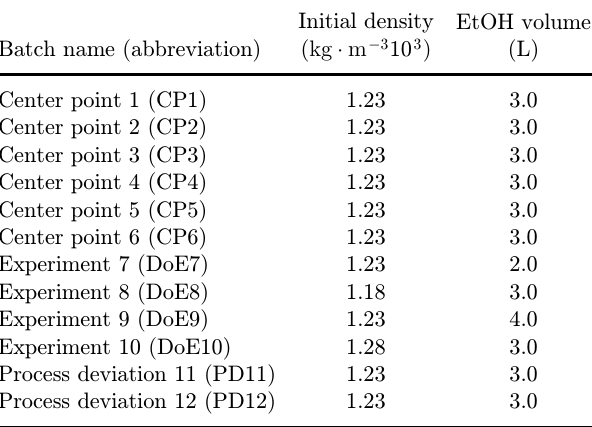
Table 1. Factor settings for the design of experiments.